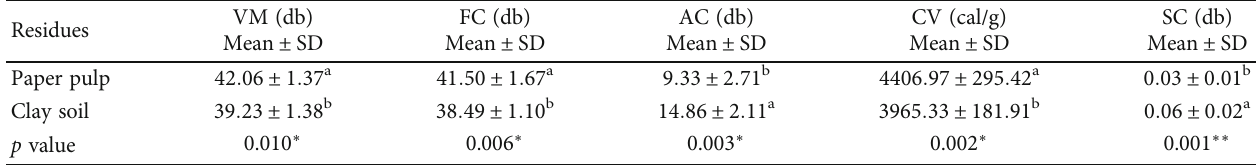
Table 3: Proximate and ultimate analysis of the sample briquette binding